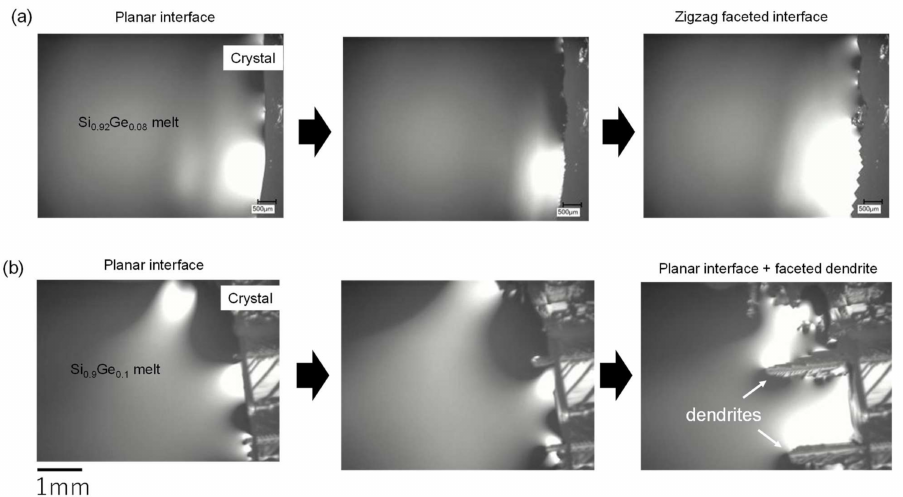
Figure 6. Observation of interface shape transformation in Si 1 − x Ge x alloys. ( a ) The planar interface changed to a zigzag faceted interface due to the instability. ( b ) Faceted dendrites appear from the planar interface due to the existence of parallel twin boundaries.